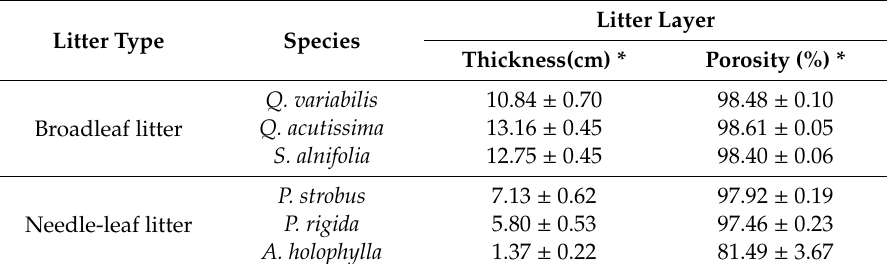
Table 2. Physical characteristics of litter layers used for rainfall simulation experiments.